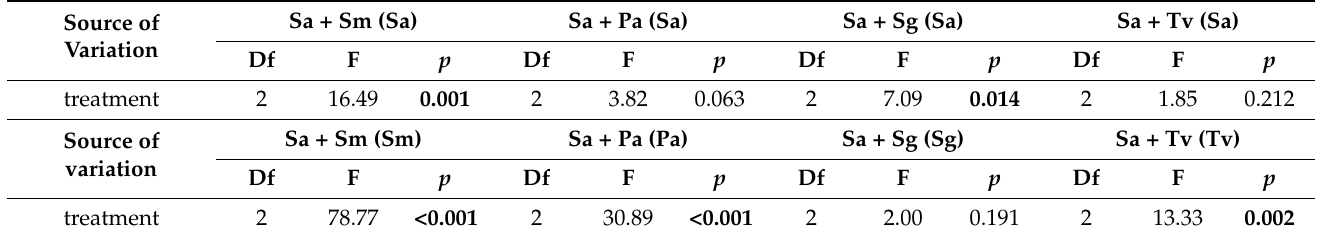
Table 3. Results of one-way ANOVA, testing the effects of interspecific interaction treatment on the final salinity of the solution in Petri dishes after seed germination in different species combina- tions. The abbreviations in brackets after species combinations denote the target species considered. Significant p values are in